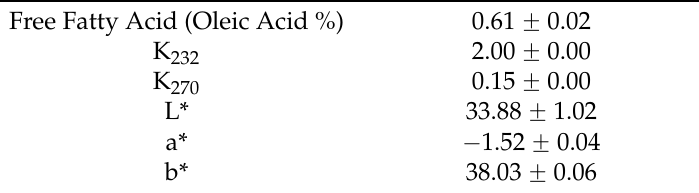
Table 1. General properties of olive oil a .